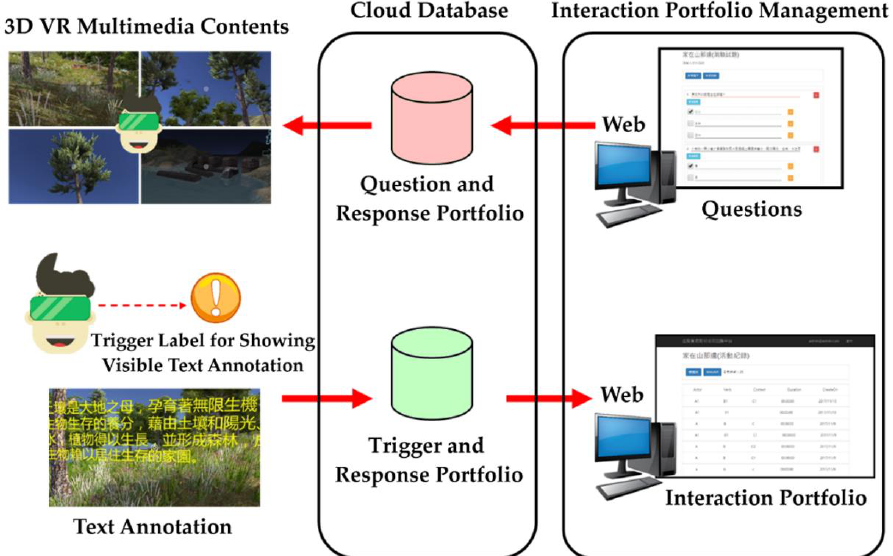
Figure 4. Summary of how to merge quizzing materials into the VRAM system.